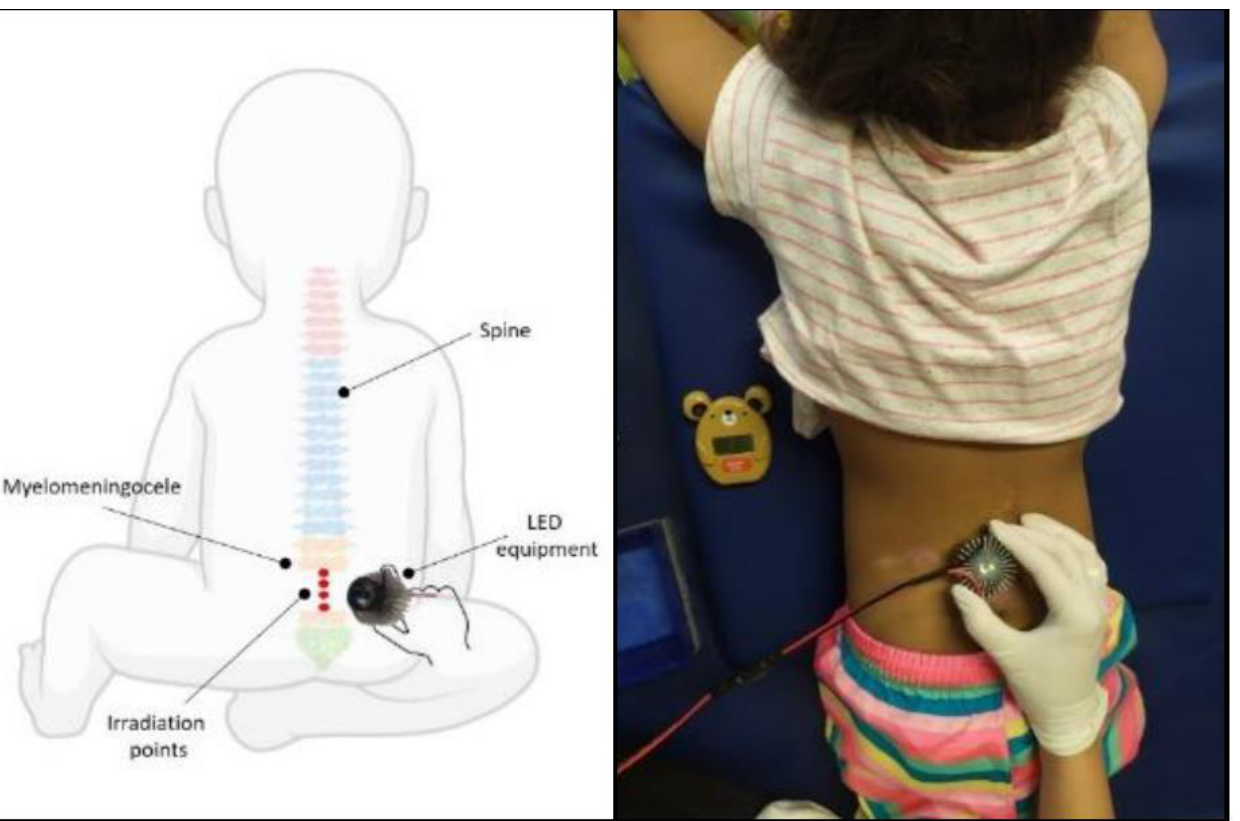
Figure 1. Positioning of participants for irradiation. Author’s personal collection.